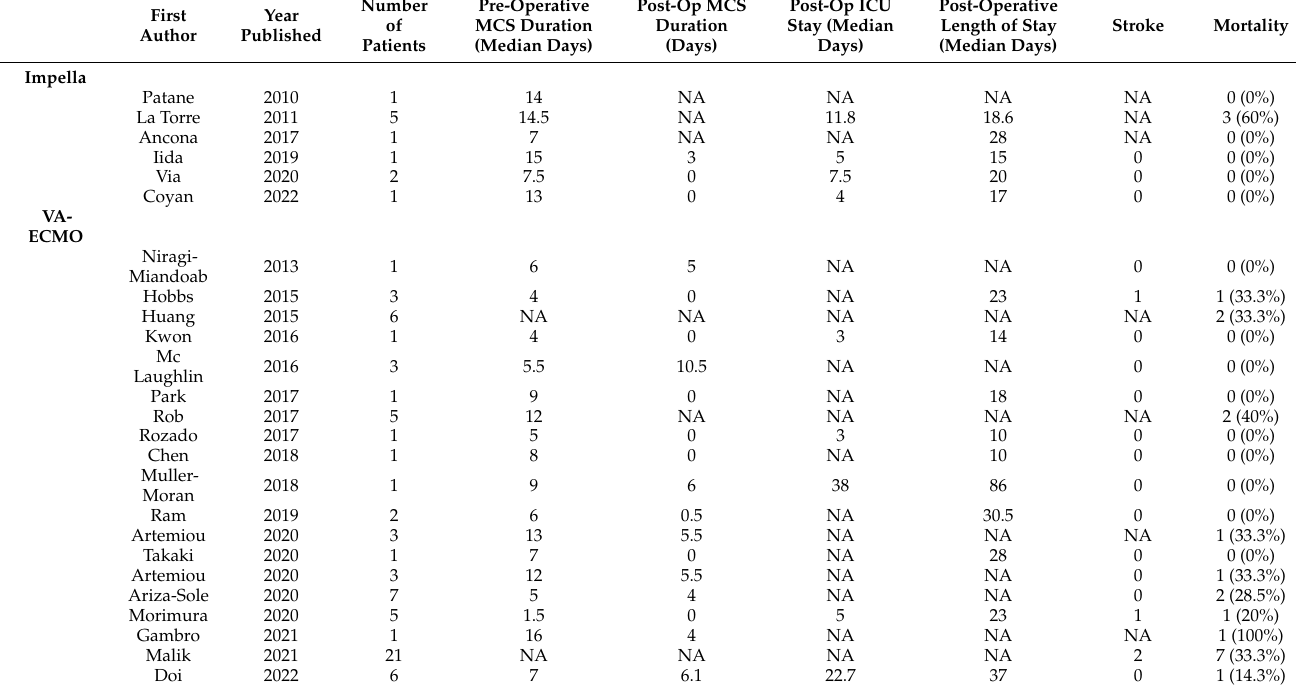
Table 1. Primary Data Obtained Via Systematic Review of Impella and VA-ECMO Bridge to PIVSR Repair.